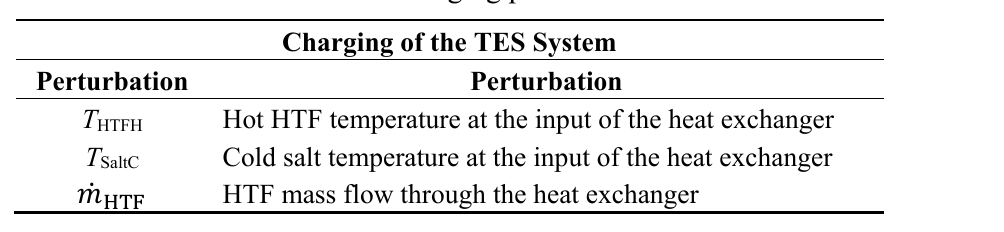
Table 4. TES charging perturbations.